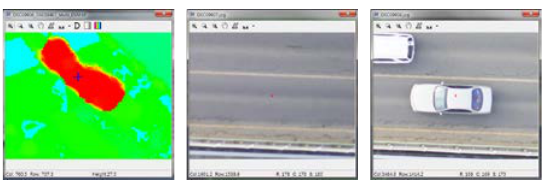
Figure 11. The blunder due to moving object (Left: DSM, Centre: left image, Right: right image)